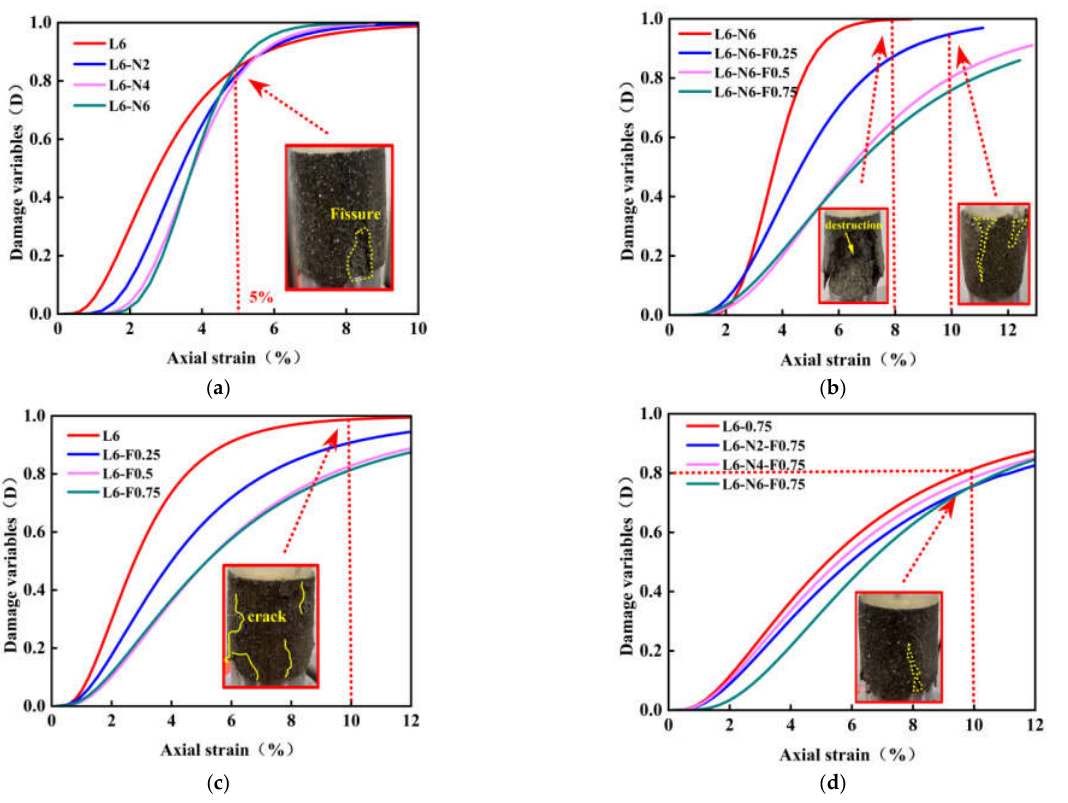
Figure 13. Mesoscopic damage evolution: ( a ) change of NLS with nano clay content; ( b ) changes of NFLS (N = 6%) with PPF content; ( c ) changes of FLS with PPF content; ( d ) change of NFLS (F = 0.75%) with nano clay content.